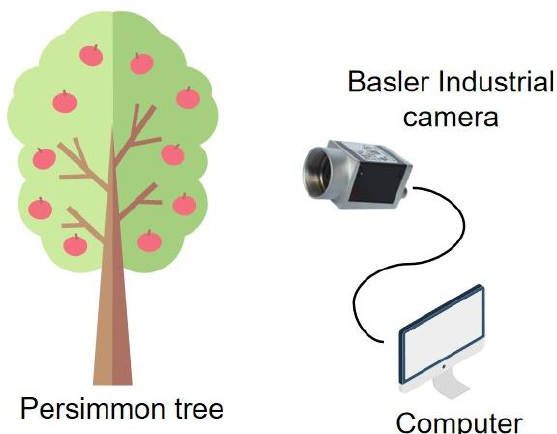
Figure 2. Actual persimmon images in a complex environment: ( a ) single fruit ; ( b ) overlapping Figure 2. Dataset acquisition device. Figure 1. Sampling under different light rays. ( a ) Normal light. ( b ) Weak light. fruit; ( c ) occlusion; ( d ) no occlusion; ( e ) long-distance shooting; and ( f ) close-range shooting. Figure 3. Dataset acquisition device.